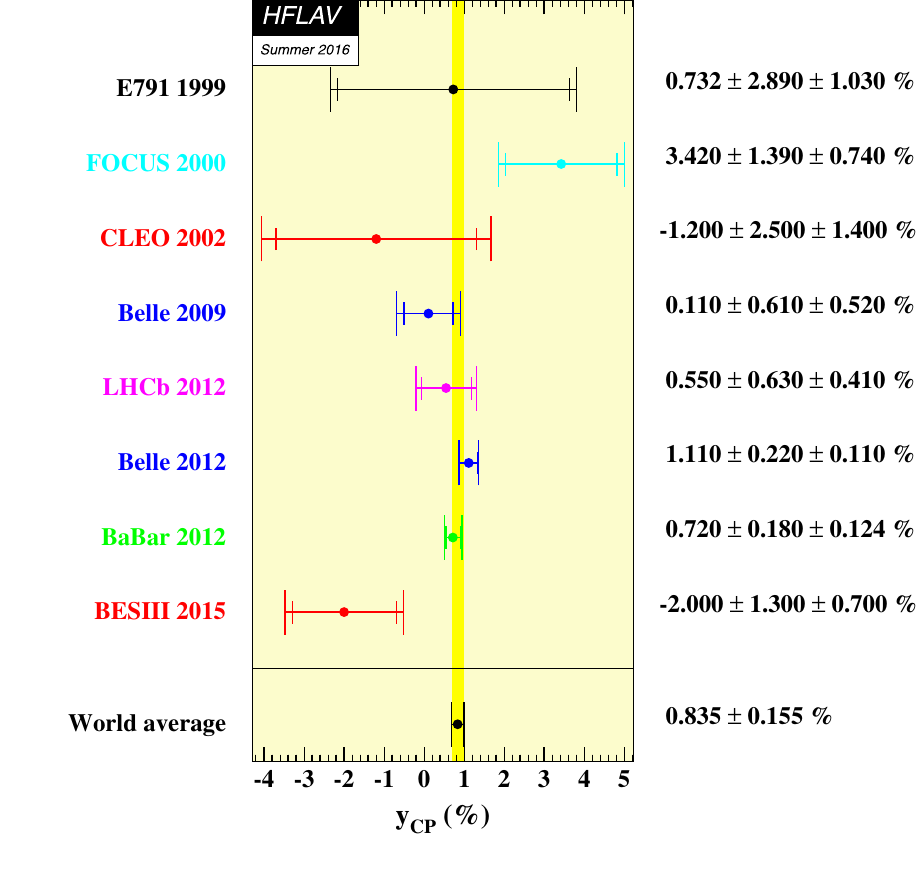
Fig. 192 World average value of y from Ref. [1060], as CP calculated